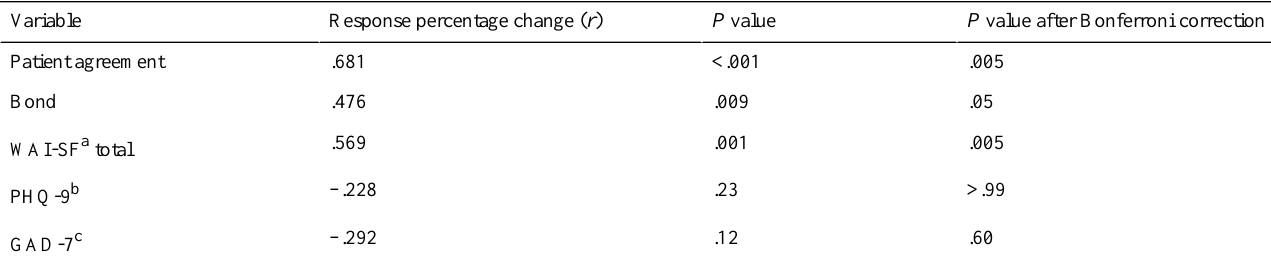
Table 1. Correlation relationship between response percentage change and the patient’s